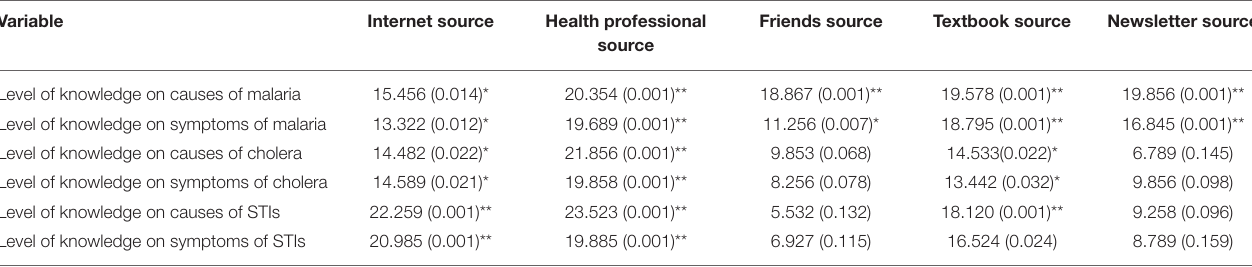
TABLE 6 | Association between level of knowledge and sources of information on